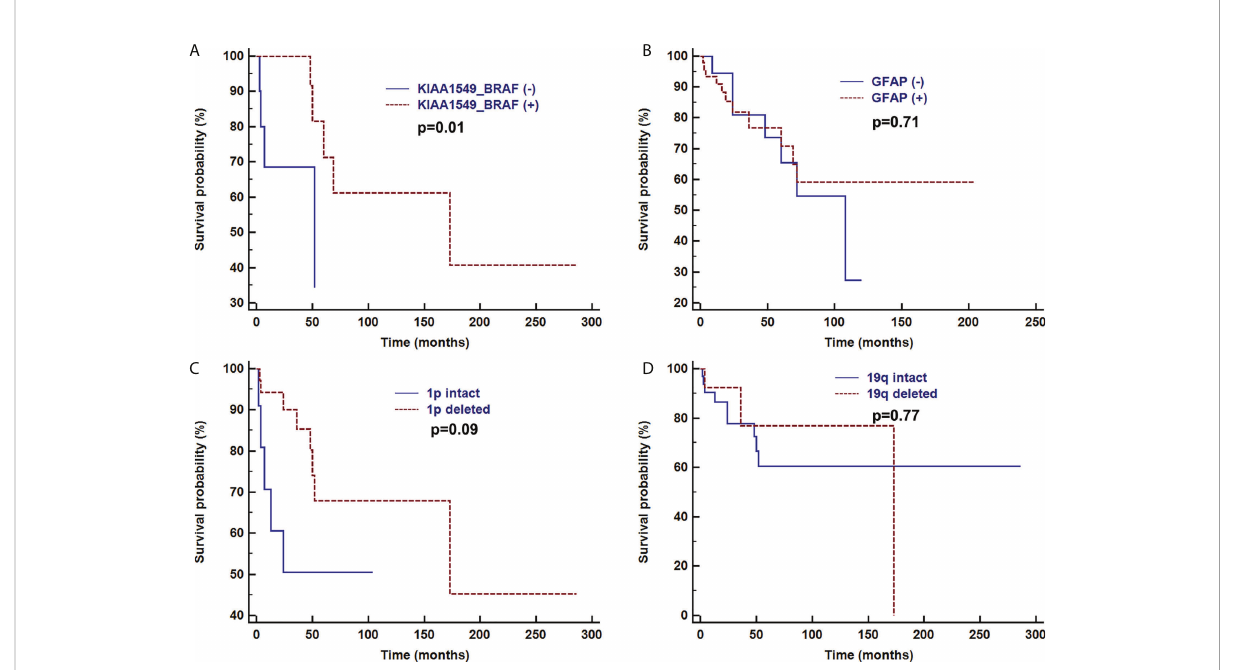
FIGURE 8 Survival curve analysis of pathological fi ndings of KIAA1549-BRAF (A) , GFAP (B) , 1p intact (C) , and 19q intact (D) were analyzed using Kaplan – Meier curves and log-rank